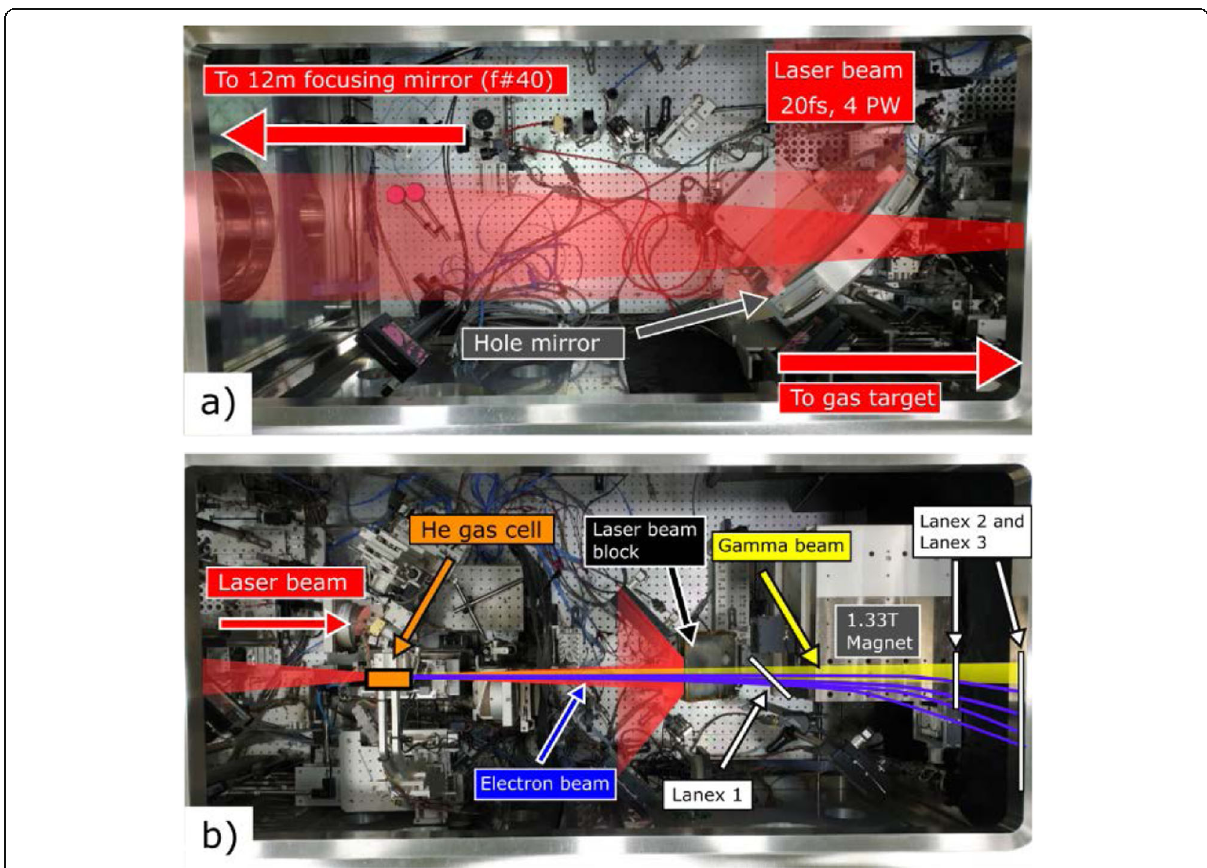
Fig. 15 Top view of the experimental chamber for LWFA at CoReLS. a Overview of laser beam transport and focusing to the target. b Setup of the target area and diagnostic of electrons after